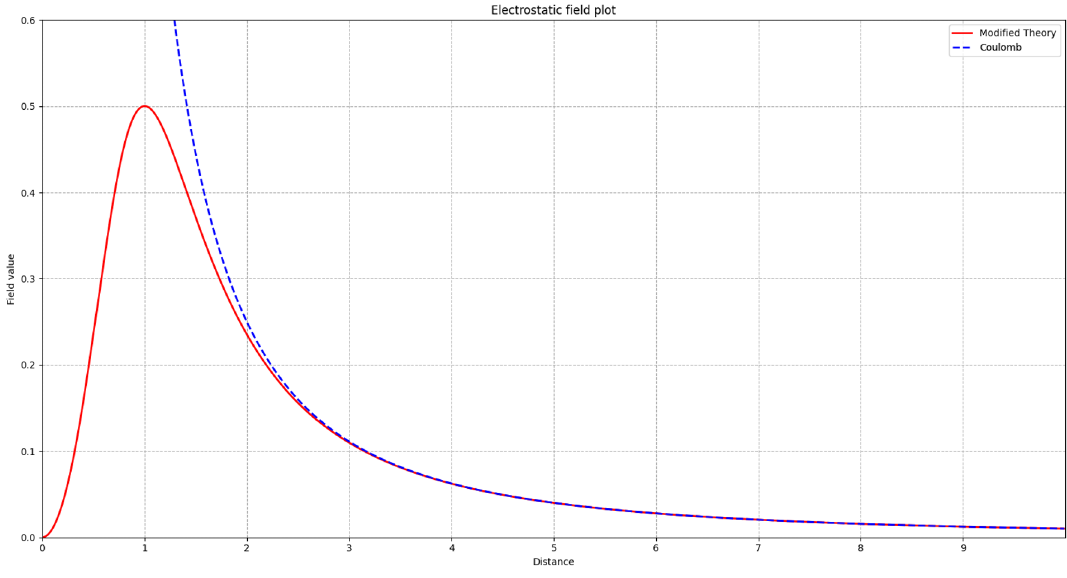
Figure 2 . The solution (4.24) compared to Coulomb